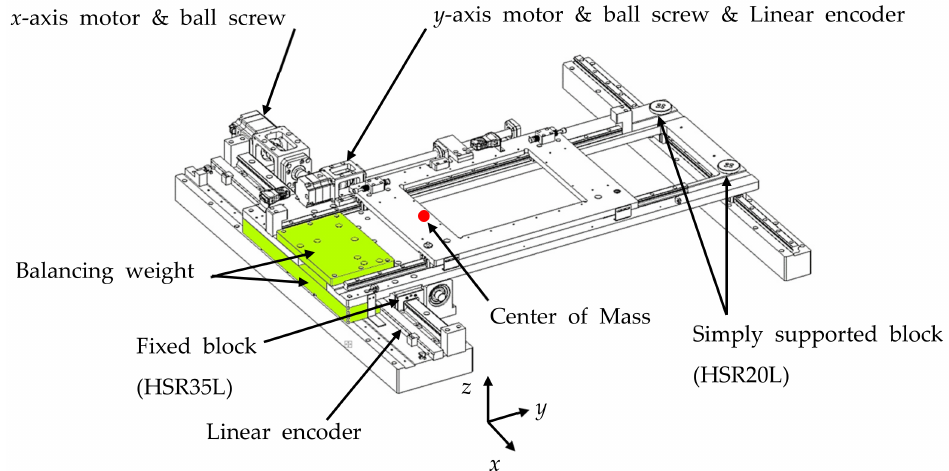
Figure 24. Design of 2-axis linear stage with balancing